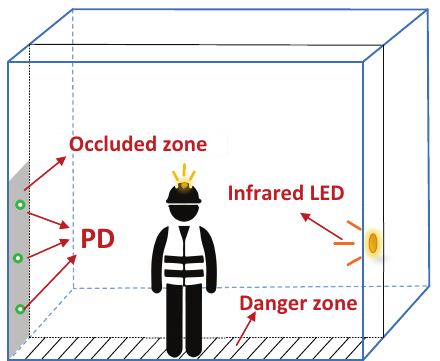
Figure 8. Monitoring whether personnel are in danger zone.